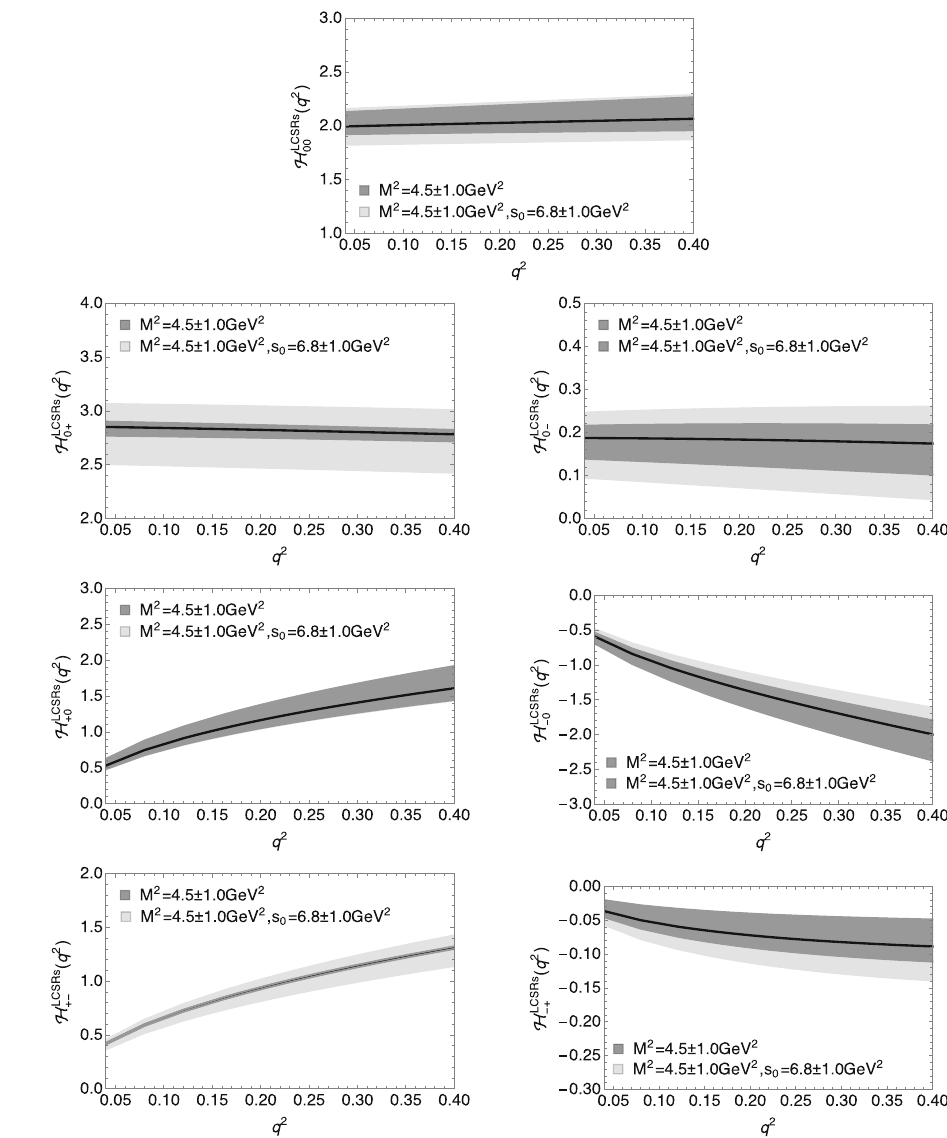
Fig. 1 The LCSRs predictions of modified helicity form factors (cid:6) ( q 2 ) ≡ H q 2 H ij ( q 2 ) with ij varying Borel mass in 4 . 5 ± 1 . 0GeV 2 and fixing continuum threshold at s 0 = 6 . 8GeV 2 (Gray), with varying Borel mass in 4 . 5 ± 1 . 0GeV 2 and